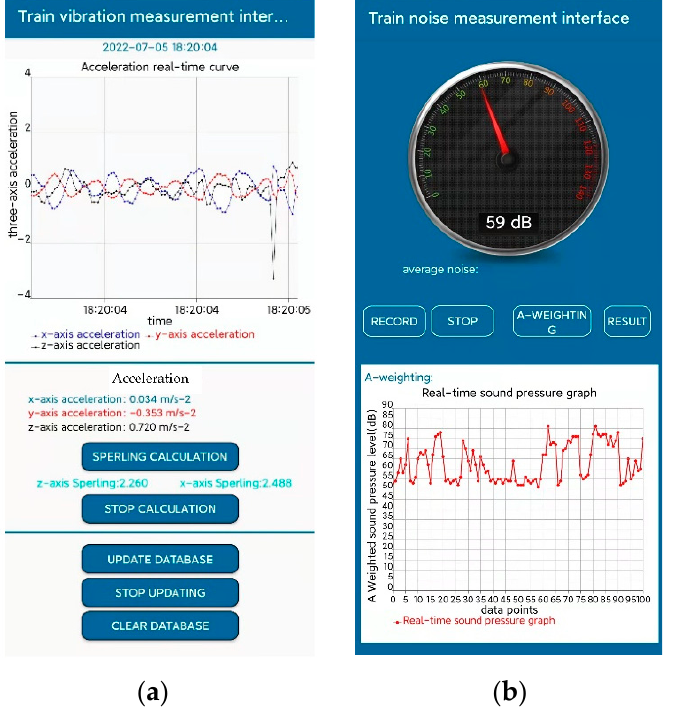
Figure 3. The user interface of the DTRCMS: ( a ) the vibration measurement interface; ( b ) the noise measurement interface.